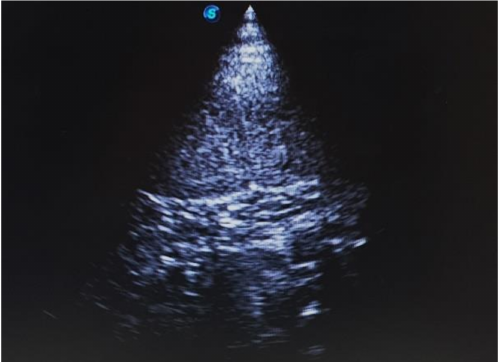
Figure 1. Uterine horn in a lion ( Panthera leo ) with pyometra. Presence of markedly distended uterine horn with echogenic intraluminal